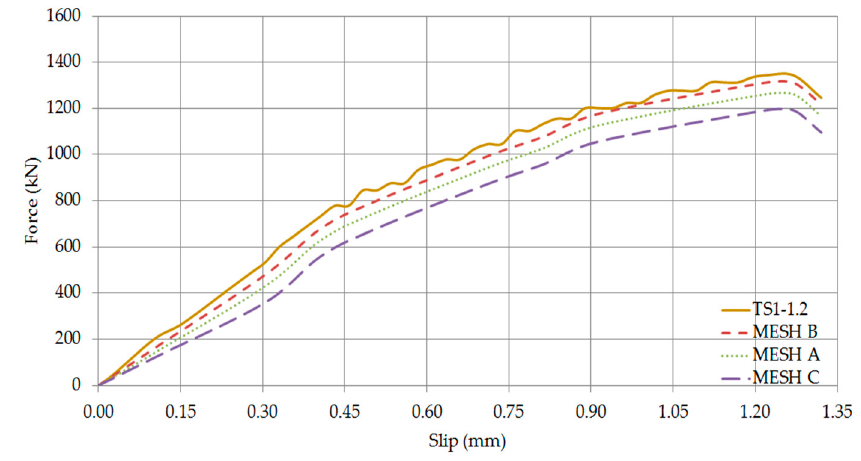
Figure 20. Axial force—Slip Curves of TS1-0.6 (Comparison of mesh densities).